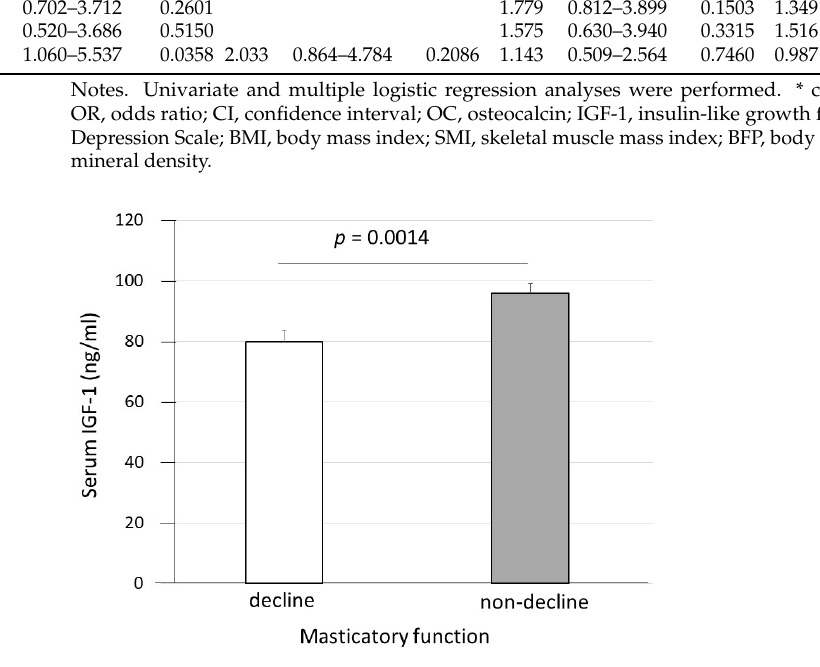
Figure 1. Comparison of IGF-1 levels between the masticatory dysfunction and non-dysfunction groups. Welch’s t -test was performed. IGF-1, insulin-like growth factor-1.